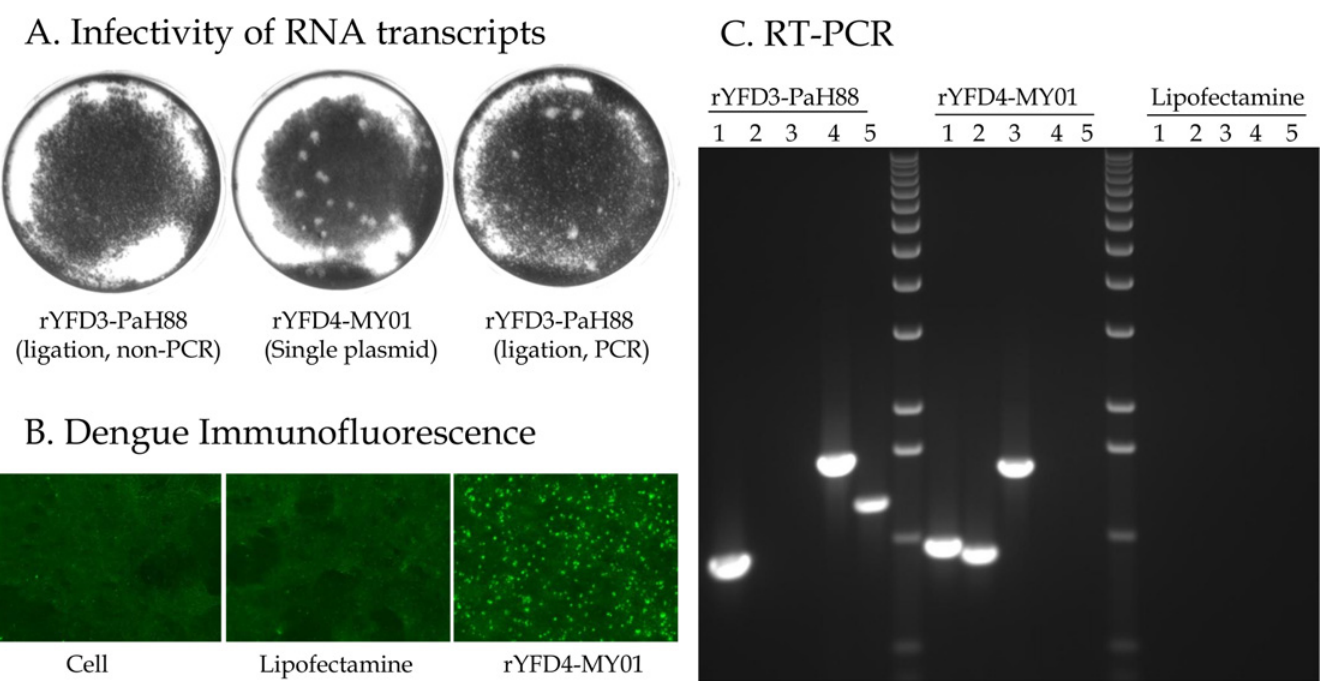
Fig 3. Confirmation of recombinant virus recovery. A . Infectivity of RNA transcripts was determined in Vero cells. B . Virus recovery was also confirmed by immunostaining using pan-flavivirus antibody 4G2. C . Virus recovery and identity was confirmed by RT-PCR using primers specific to YF (1), D4-MY01 (2), D4-MY01/YF junction (3), 5 ’ YF/D3 junction (4) and 3 ’ YF/D3 junction